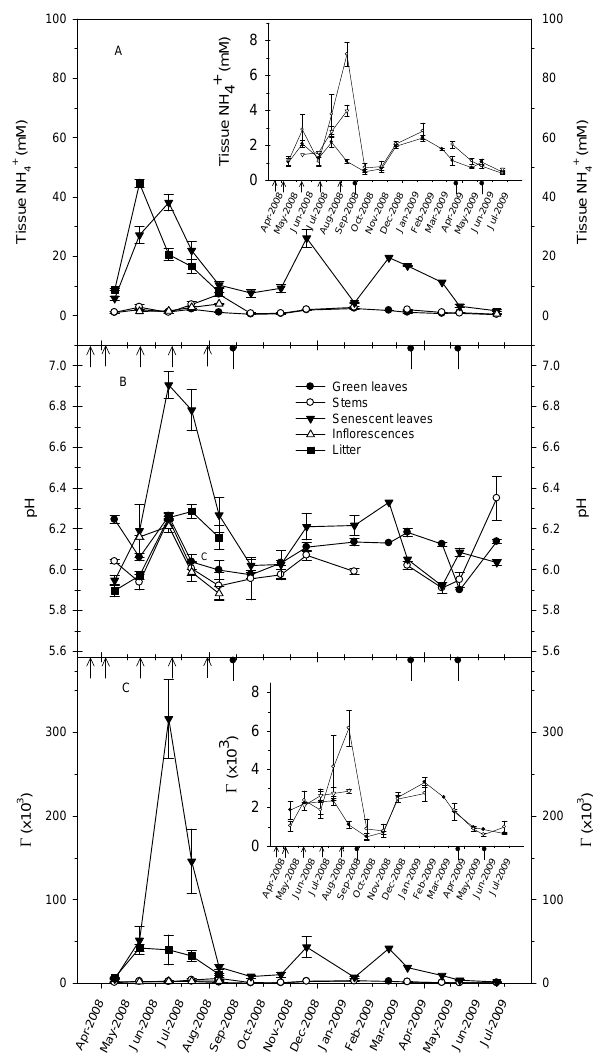
Fig. 5. Seasonal variations in bulk tissue NH 4+ concentration (A), pH (B) and Γ (C) in different tissues of ryegrass. Inserts in A and C show bulk tissue NH 4 + concentration and Γ , respectively, in green leaves, stems and inflorescences at a different scaling in order to reveal the fluctuations. The bar with arrow represents N application as NH 4 NO 3 ; the bar with solid circle represents N application as urea.